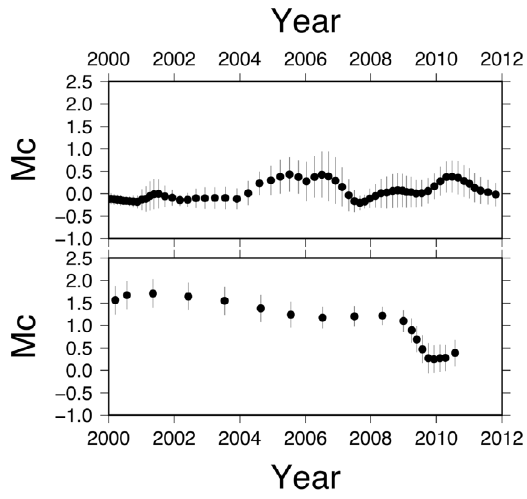
Figure 2. Temporal variation of the magnitude of completeness (Mc) for events detected at BKE station (top) and the Mc for located events